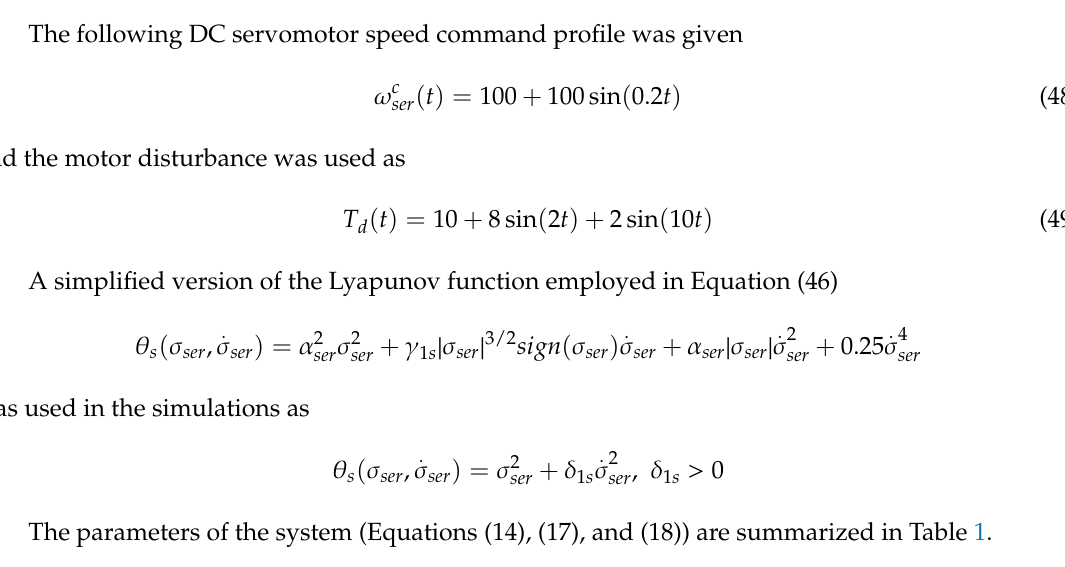
Table 1. The parameters of the systems (14), (17), and